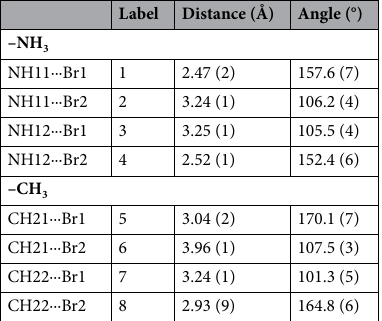
Table 4. Possible H-bond distances of MA at 2 K.